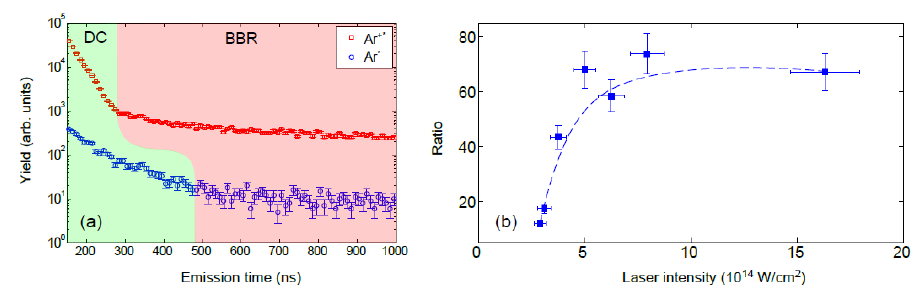
Fig. 2 (a) Yields of the measured Rydberg electrons from Ar * (blue circles) and Ar +* (red squares) over the emission time. (b) The ratios of trapping probability between the single and double ionization processes as a function of laser peak intensity. The blue dashed line is a fitting curve to guide the eyes